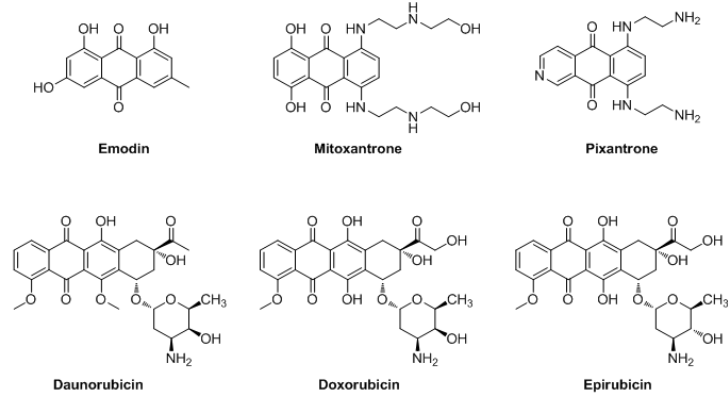
Figure 1. Structures of emodin and antitumor drugs with anthraquinone skeleton.